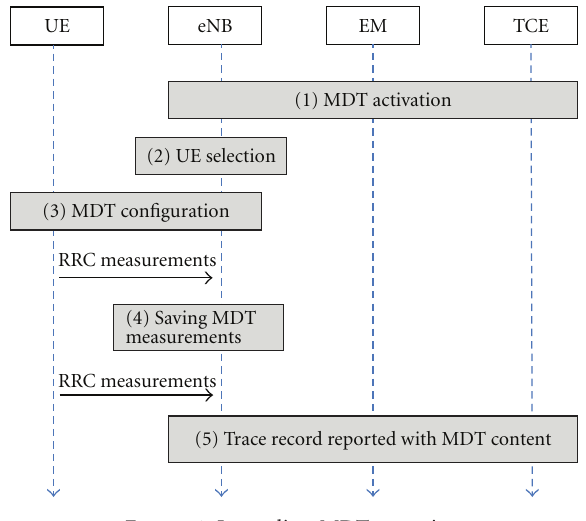
Figure 1: Immediate MDT